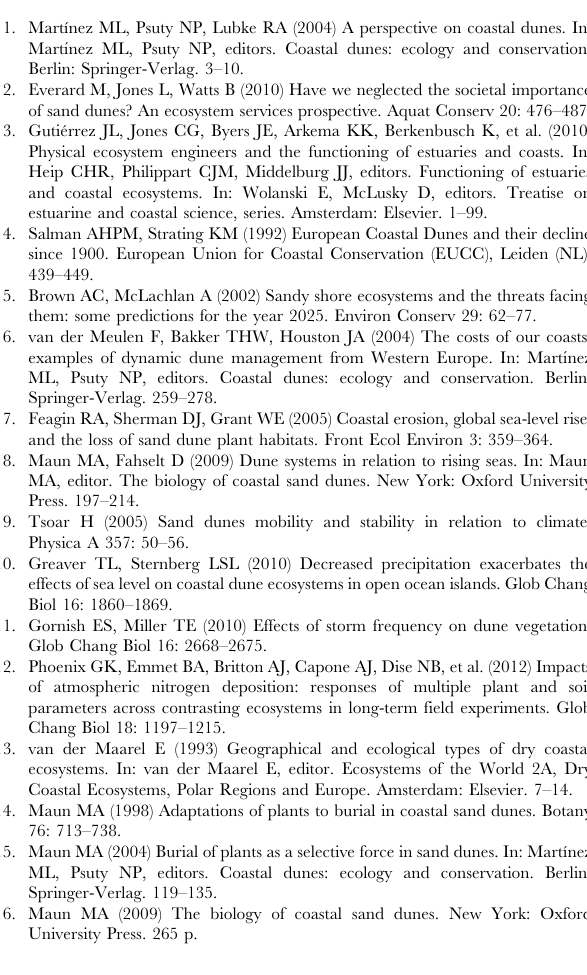
Table S3 Results of a posteriori pair-wise comparisons for the significant interaction terms, burial 6 nutrient and area 6 nutrient, detected by PERMANOVA